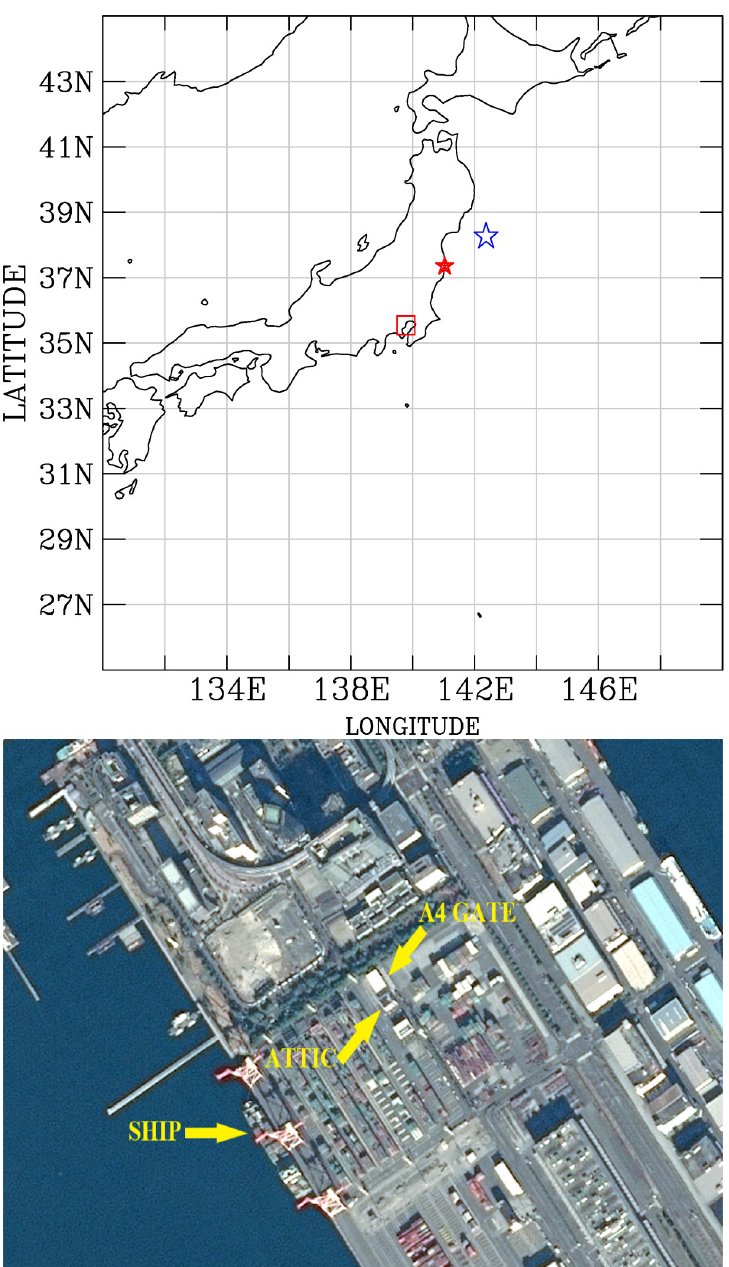
Fig 1. Sites of air dose measurements. (Upper panel) Locations for the measurements of the radioactivity dose rates at the Port of Tokyo site (open red square), 11-March-2011 earthquake epicenter (38.322˚ N ; 142.369˚ E ; open blue star), and the FDNPS (solid red star). Map made with Natural Earth. Free vector and raster map data at naturalearthdata.com. (Lower panel) A magnified satellite image (Map data: With permission from CSRSR under the CC BY 4.0 license), showing the attic area in the Port of Tokyo office (ATTIC; 35.6150˚ N ; 139.7806˚ E ; A4 gate (GATE; 35.6150˚ N , 139.7806˚ E ), and location for calling ships (SHIP; 35.6121˚ N , 139.7783˚ E ).